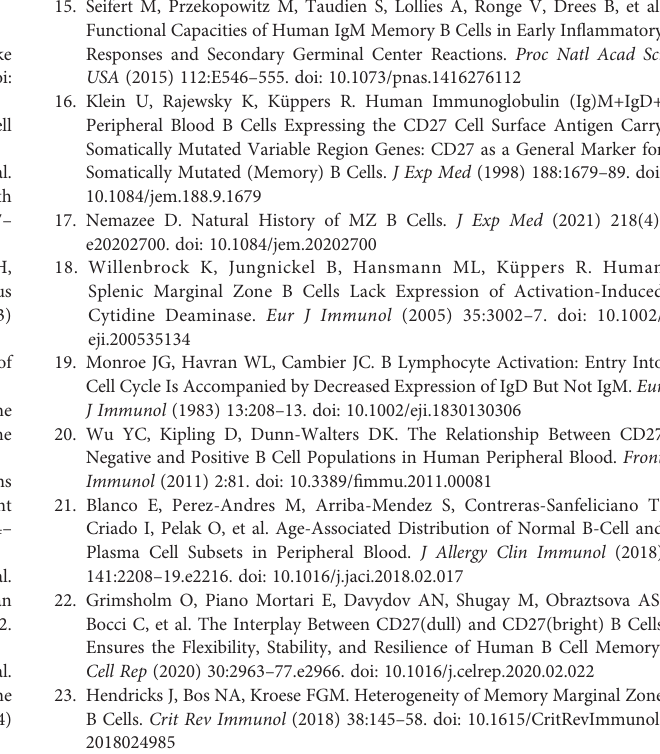
Supplementary Figure 1 | Impact of age on the sMZ B cell heterogeneity of fi ve healthy donors. (A) Unsupervised t-SNE analysis of most differentially expressed genes(MANOVA q< 0.05,31 genes, Table S2 ) among sMZB cellsfrom fi vedonors. The fi vedonors areseparatelydisplayed. (B) Supervised PCA of23 genesassociated with hallmark molecules distinguishing NBCs from MBCs, and sMZ B cells, and NOTCH-signalling genes ( Table S2 ). The fi ve donors are separately